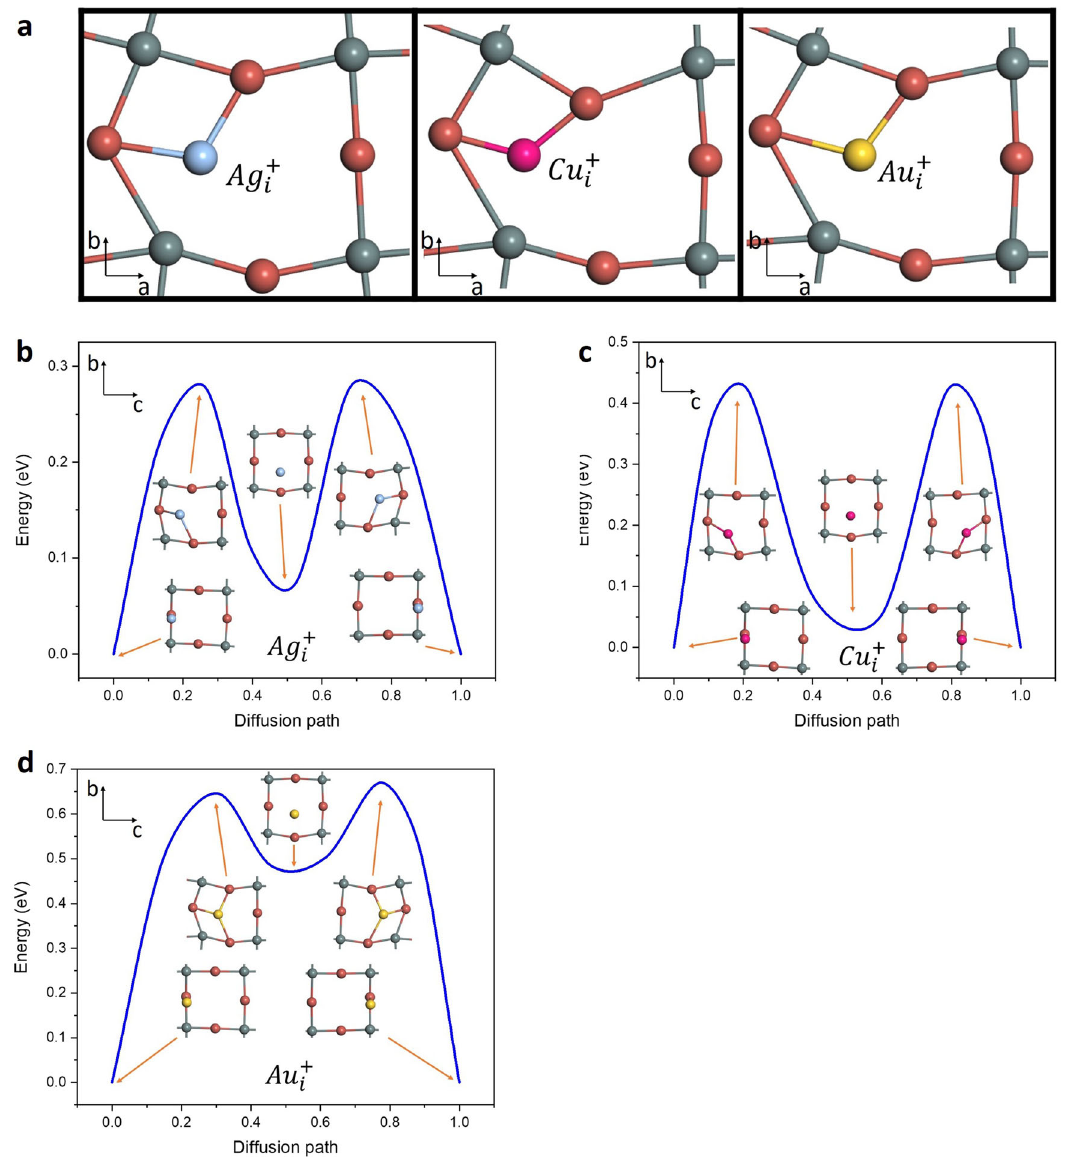
; Ag þ ; and Cu þ i i i , Cu þ , and i i